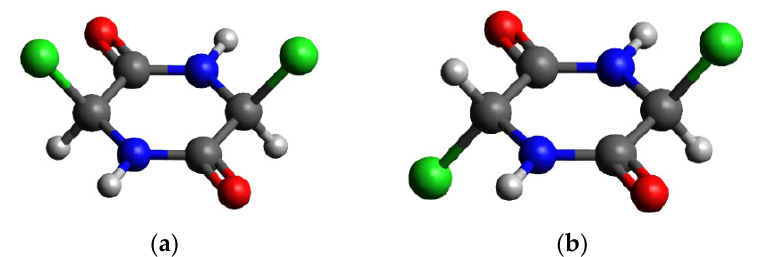
Figure 1. 3D Chemical structure of generic cyclodipeptides (CDPs) obtained from the cyclization of L -homochiral ( a ) or D,L -heterochiral ( b ) dipeptides. Side chains are represented as a generic green sphere and the rest of the atom types are represented using the standard CPK model.